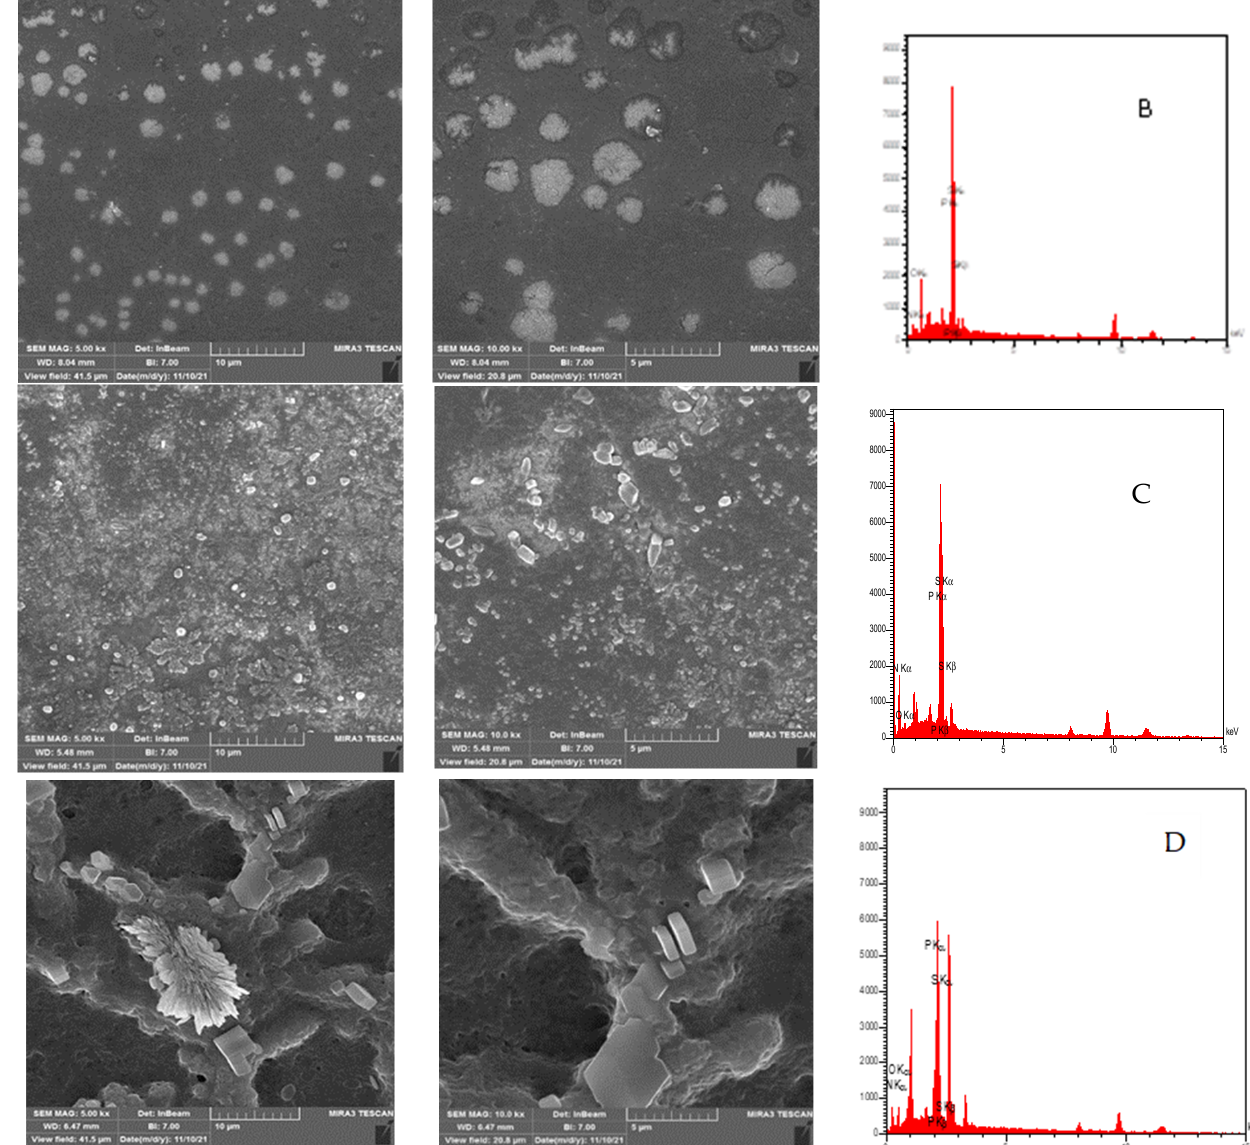
Figure 1. FE-SEM images of the P( β -CD)-modified GCE ( A ), the P( β -CD)-Ab1-modified GCE ( B ), the P( β -CD)-Ab1-BSA-2-AG-modified GCE ( C ), and the P( β -CD)-Ab1-BSA-2-AG-Ab2-HRP/AuNPs/TB/GLU-modified GCE ( D ) at different magnifications along with EDSs.